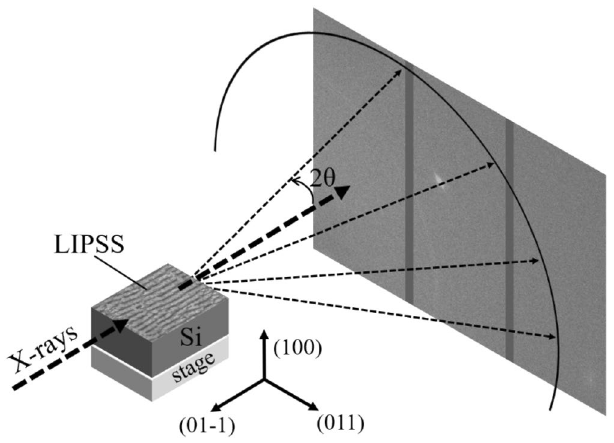
Figure 1. Schematic diagram for the XRD measurement setup. We performed XRD analysis using high-energy x-rays (30 keV). Transmitted x-ray diffraction light was detected by two-dimensional detector. The dotted arrows show the direction of the x-rays and the solid arrows represent the crystal orientation of Si substrate. The measurement position was adjusted by moving a stage under the Si